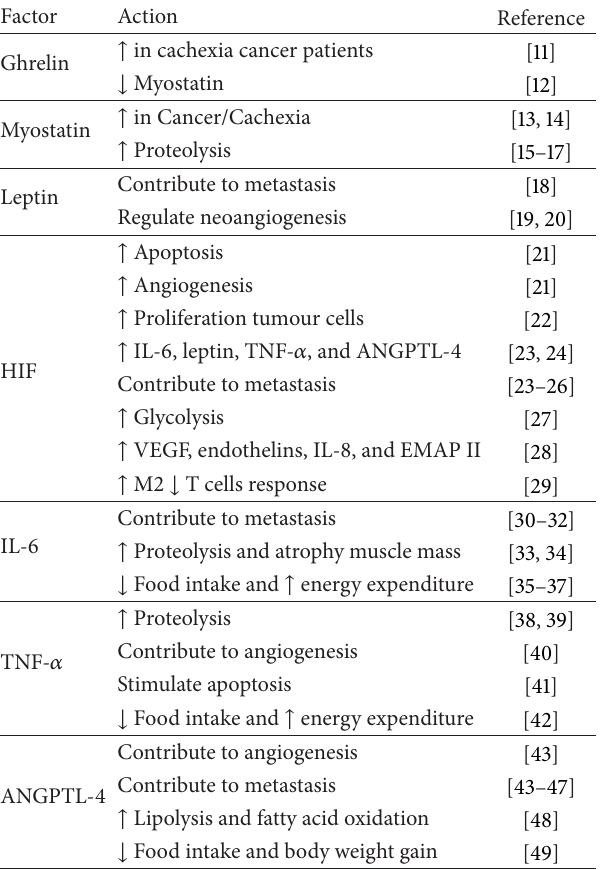
Table 1: Summary of the effect of some factors involved in the development of cancer cachexia and